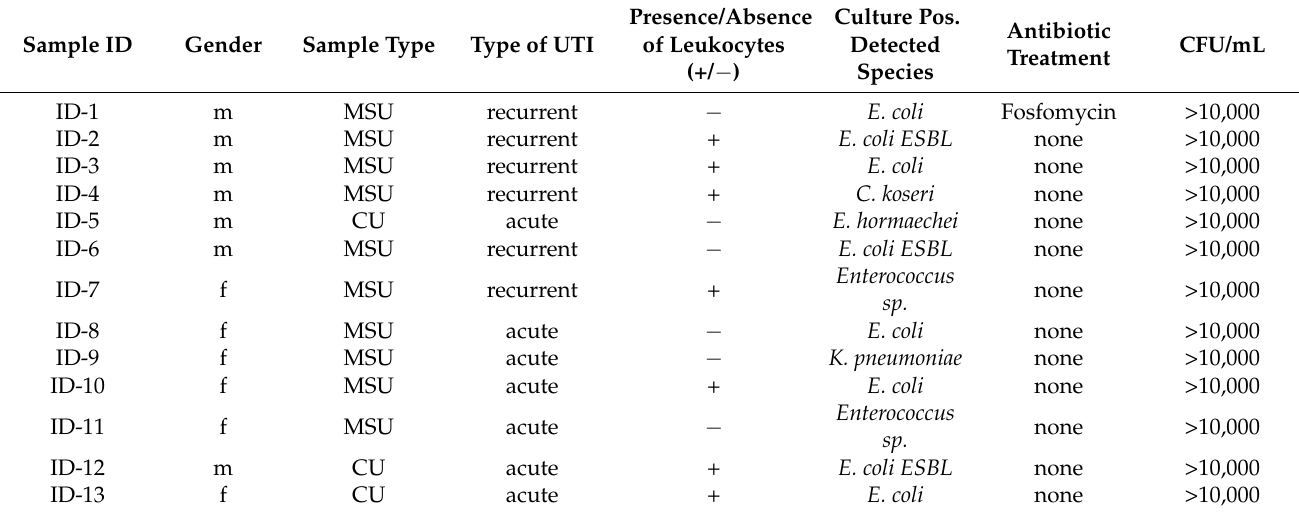
Table 1. Set of septic urine